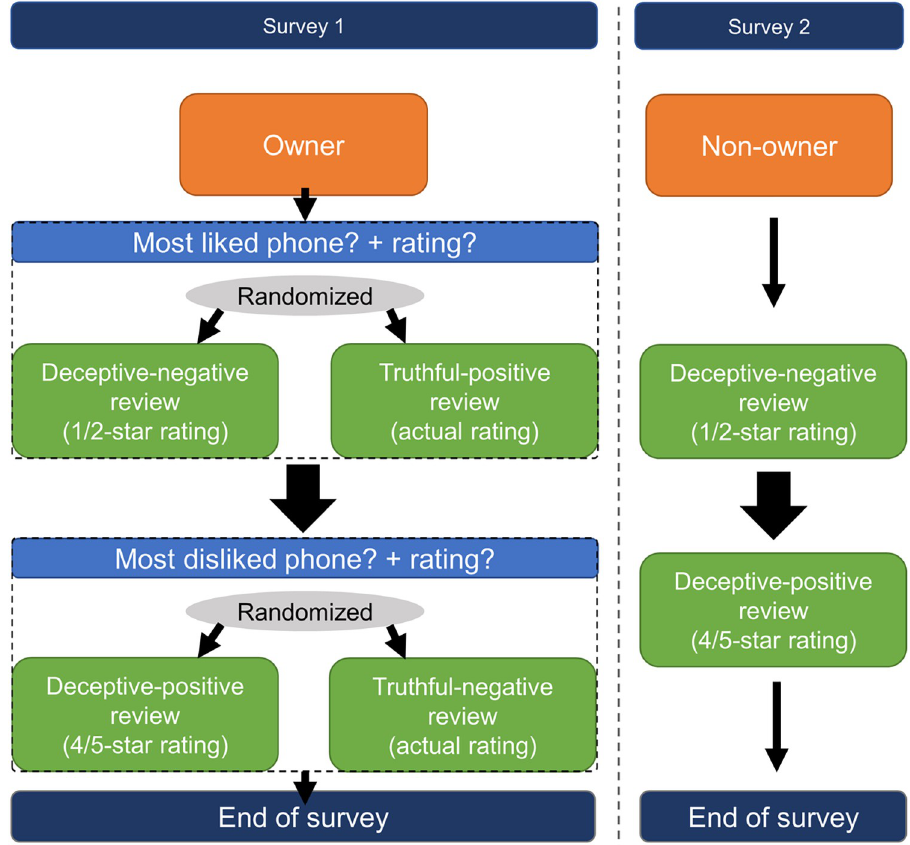
Fig 1. Collecting procedure of reviews from Prolific